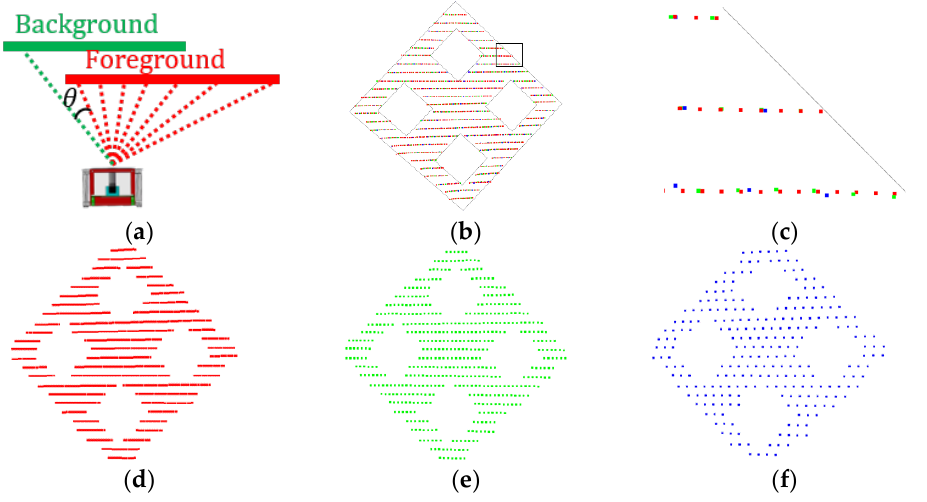
Figure 4. Point clouds distribution map with different 𝜃s , ( a ) is the top view of LiDAR, ( b ) is point clouds of three different 𝜃s and ( c ) is a partial diagram (black rectangle) of ( b ). Red point in ( d ) is 𝜃 = 0.1°, green point in ( e ) is 𝜃 = 0.2°, and blue point in ( f ) is 𝜃 = 0.4°.